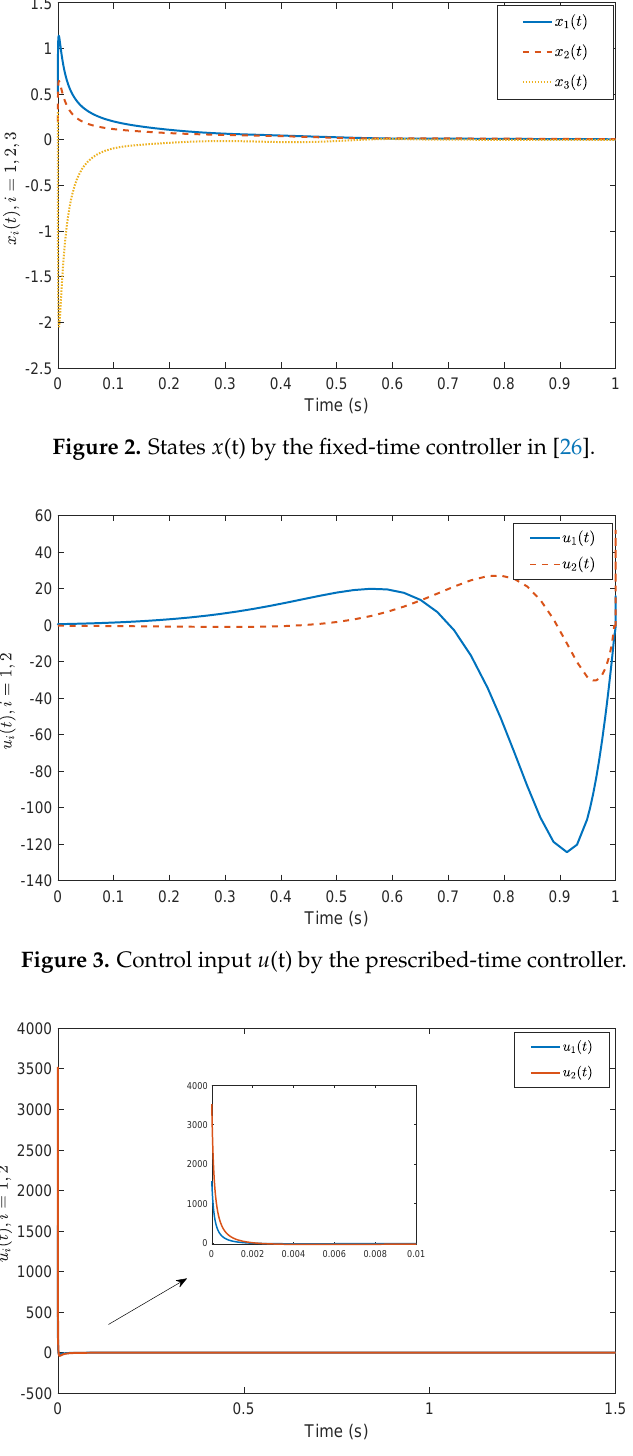
Figure 4. Control input u (t) by the fixed-time controller in